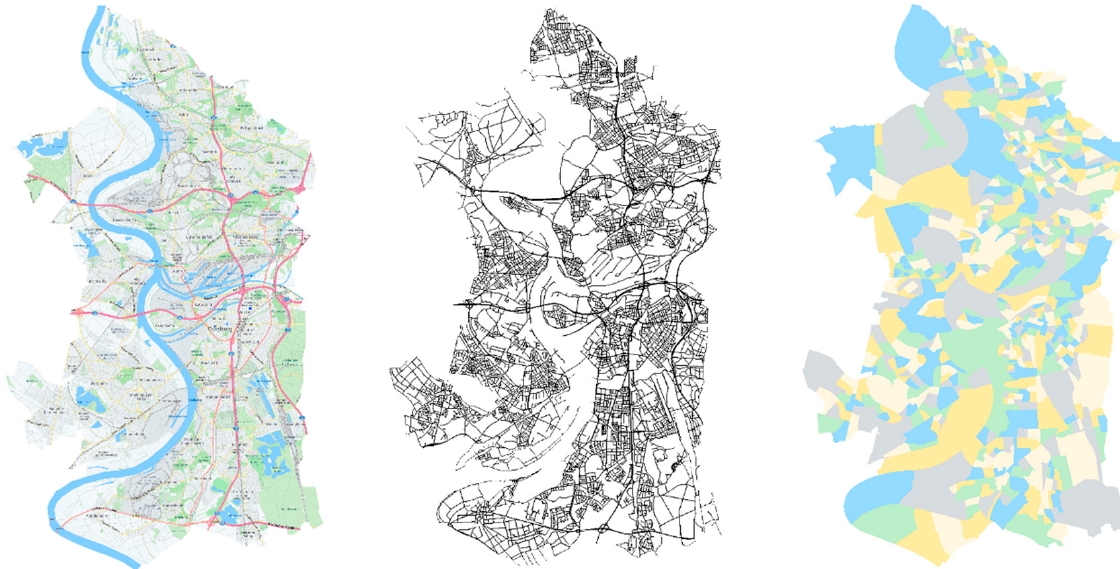
Figure 3. Map (Source: HERE map), road network, and traffic demand partition of city Duisburg.